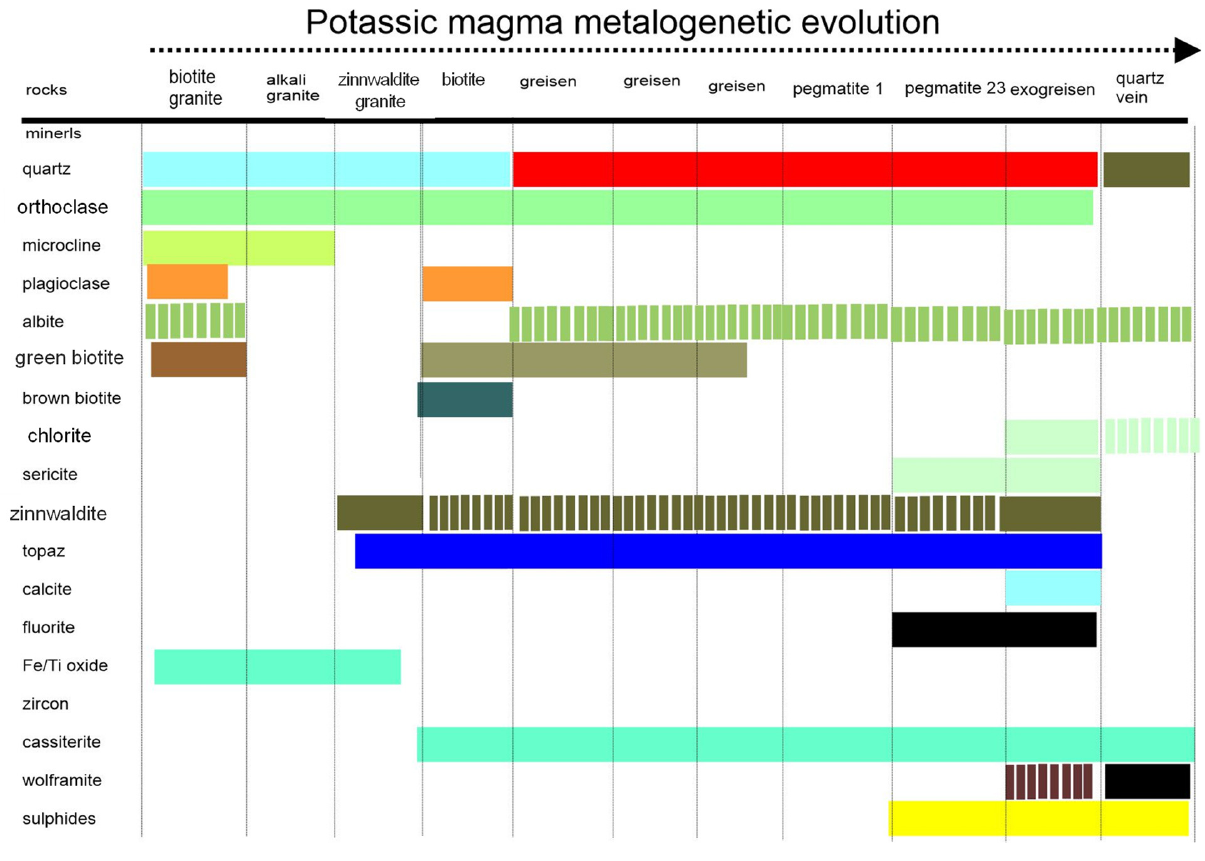
Figure 22. Paragenetic evolution of mineralized Massangana Massif rocks. The evolution of potas- sium magma and hydrothermal solutions is responsible for the mineralization of rare metals in the Massangana Massif.